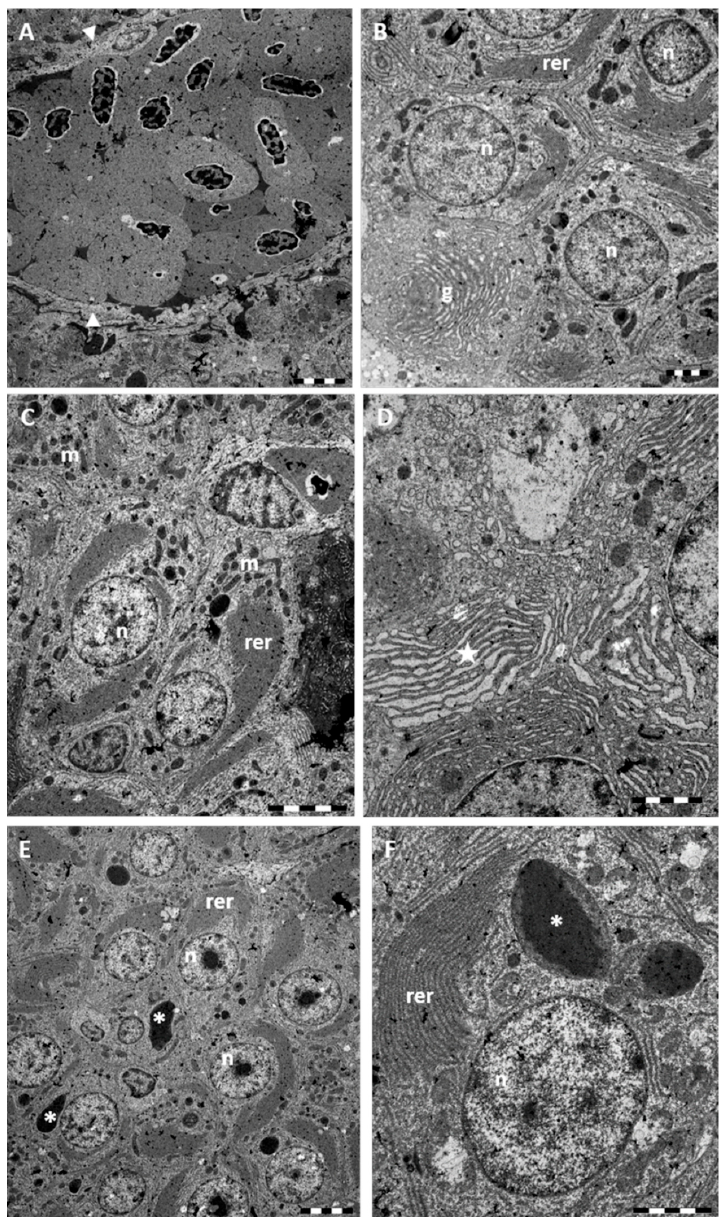
Figure 6. TEM micrographs of Danio rerio liver section after 96 h of exposure to 38.5 μ g/L HgCl 2 . ( A ) Occlusion of blood vessel and damaged Disse’s space (arrowheads). Bar 5 μ m; ( B ) RER appear conspicuous and fills most part of the cytoplasm. Note the well-developed Golgi apparatus (g). Some degenerate hepatocyte with pyknotic nuclei can be seen. Bar 2 μ m; ( C ) Numerous mitochondria (m) are scattered through the cytoplasm. Bar 5 μ m; ( D ) High magnification of RER; note at several points, swelling of cisternae (star). Bar 2 μ m; ( E ) In the central portion of nuclei a large nucleolus is evident. In the cytoplasm we can observe the abundant RER and the presence of large electron-dense granules (asterisk) of variable dimension. Bar 5 μ m; ( F ) High magnification of atypical granules (asterisk). Bar 2 μ m. n =nucleus; rer = rough endoplasmic reticulum.